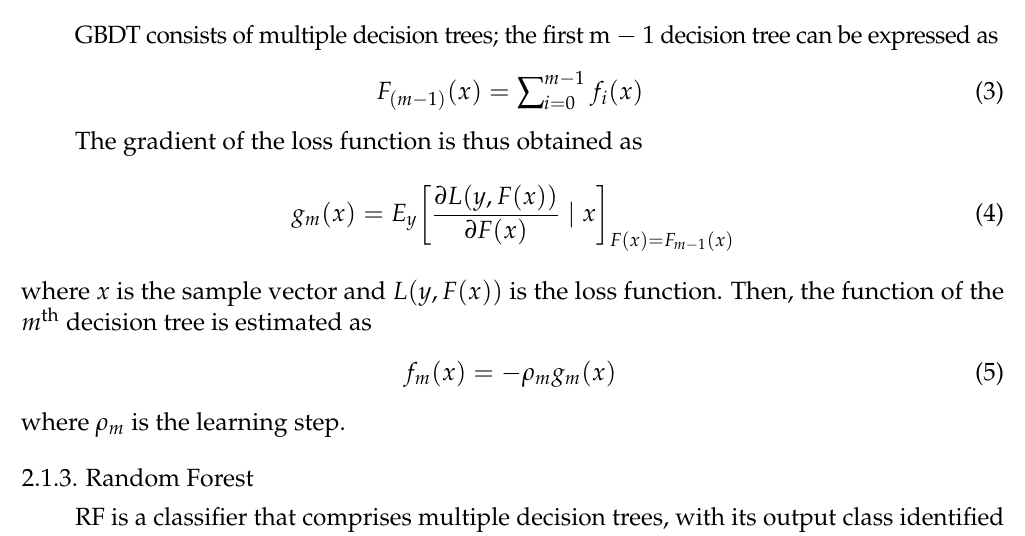
Figure 3. Basic principle of GBDT.